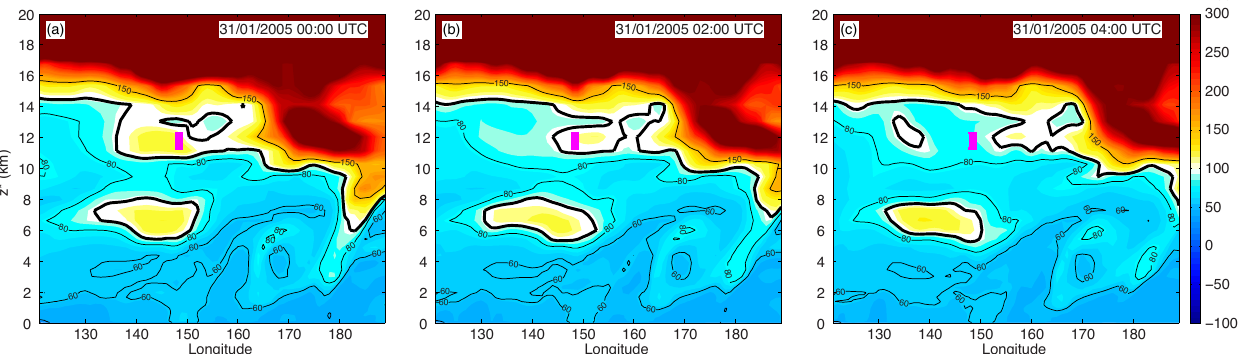
Fig. 2. Pressure altitude ( z ∗ ) by longitude (120 ◦ E–190 ◦ E) plots of simulated ozone (colors: blue shows low values, red high values, unit: ppb) at 29.5 ◦ N on 31 January 2005 (a) 00:00UTC, (b) 02:00 UTC, and (c) 04:00UTC. The thin black contour lines represent ozone of 60, 80, and 150ppb. The thick black contour lines define the 100-ppb ozone surface (approximately the tropopause). The magenta squares correspond to the same CTM grid